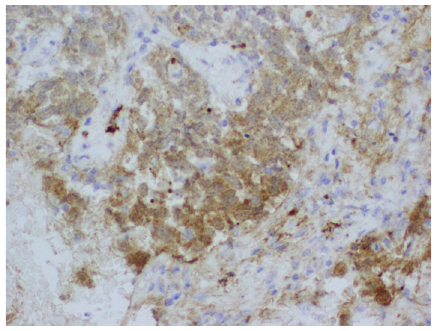
Figure 4: 𝛽 -HCG positivity in foci suggestive of choriocarcinoma- tous component.